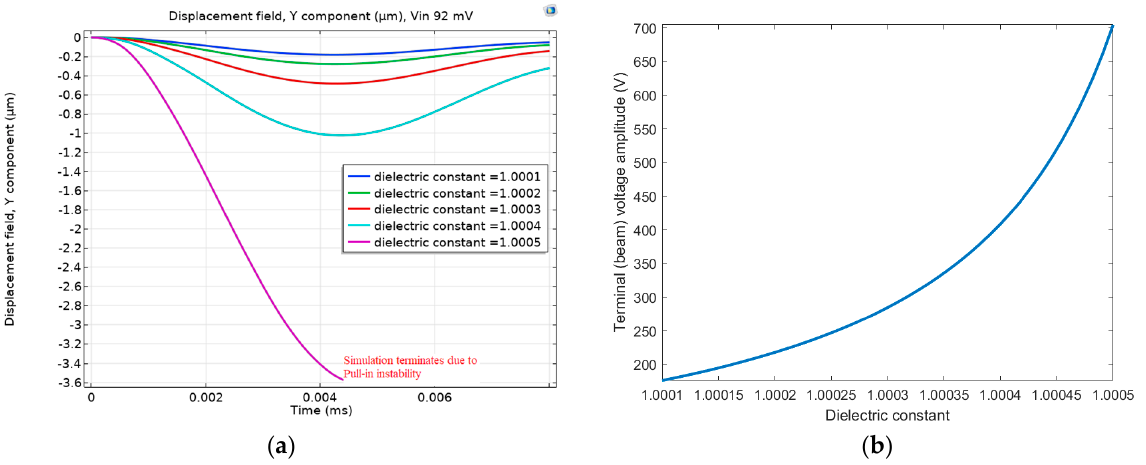
Figure 5. ( a ) The displacement at resonance excitation at 3.8 MHz with 92 mV input voltage. ( b ) The voltage amplification amplitude dependence on the dielectric constant shows the effect of electrical resonance excitation (3.8 MHz).